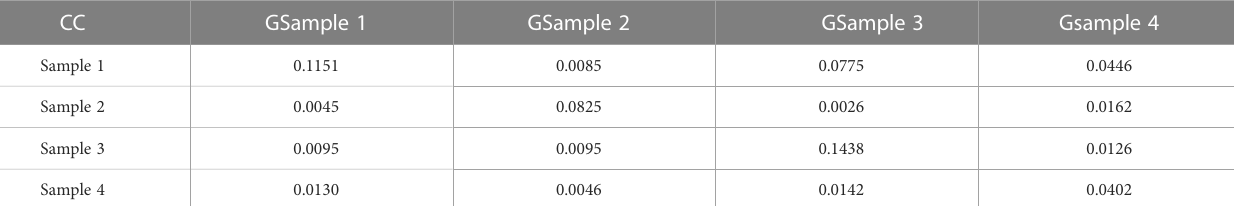
TABLE 3 Correlation coef fi cient results.